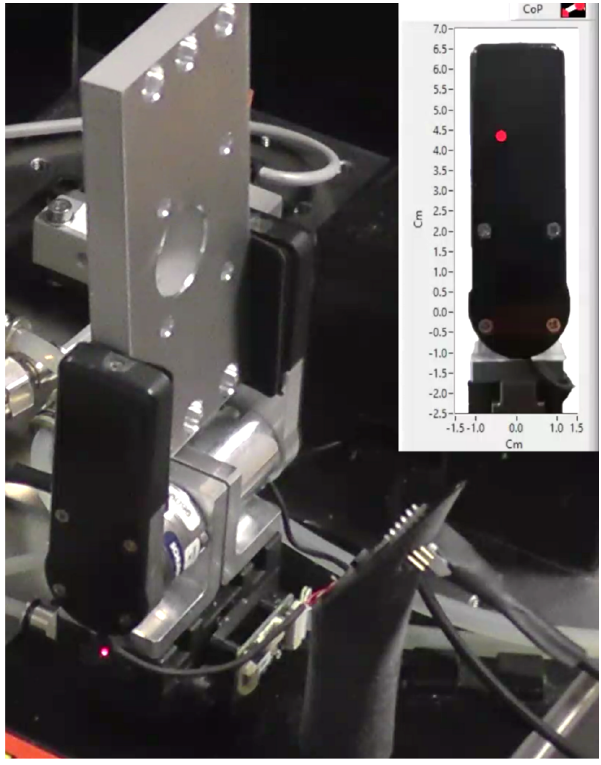
Figure 12. Experiment with the holed metal piece. The red dot represents the estimated